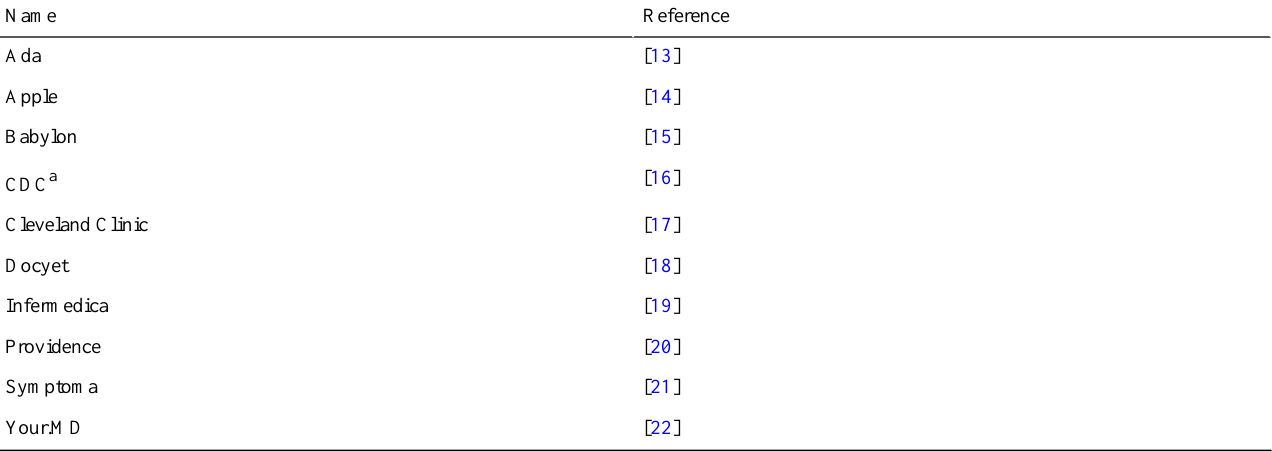
Table 1. List of web-based COVID-19 symptom checkers included in this